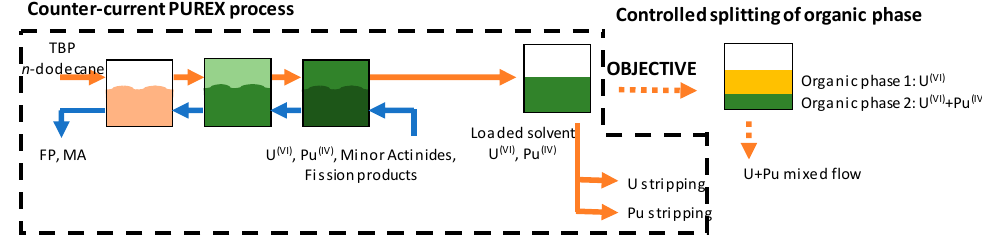
Figure 1. Schematic description of the first stage of the spent nuclear fuel reprocessing process (U and Pu extraction) and objective of the new proposed process.